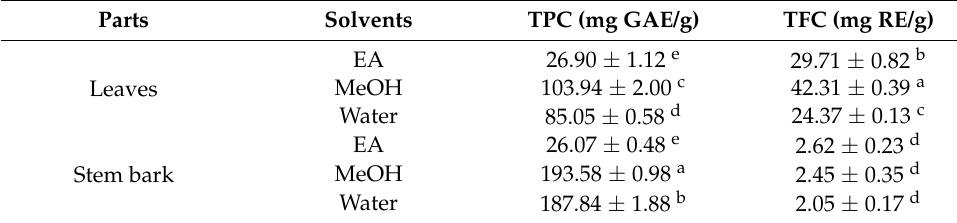
Table 1. Total phenolic (TPC) and flavonoid (TFC) contents of the tested extracts. Parts Solvents TPC (mg GAE/g) TFC (mg RE/g)